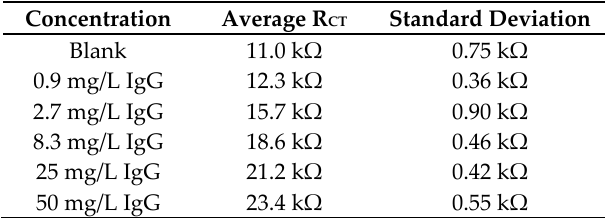
Figure 2. EIS spectra of the functionalized sensor for (I) buffer; (II) 0.9 mg/L; (III) 2.7 mg/L; (IV) 8.3 mg/L; (V) 25 mg/L; and (VI) 50 mg/L IgG. Table 1. Average R CT and standard deviations for samples with different IgG